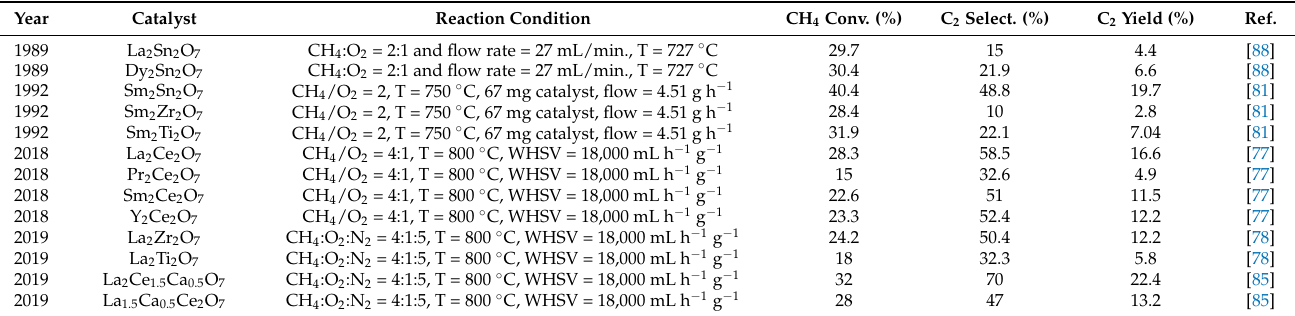
Table 3. OCM reaction over various pyrochlore